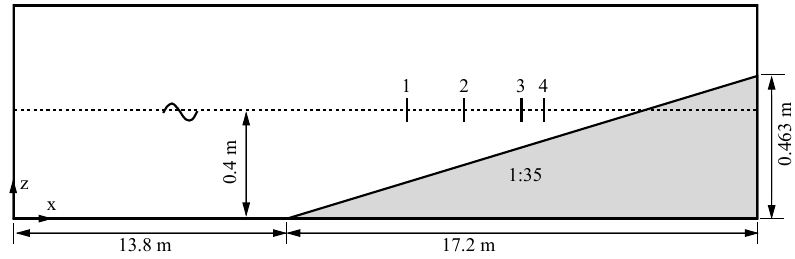
Figure 6. Numerical wave tank setup for wave breaking over a mild